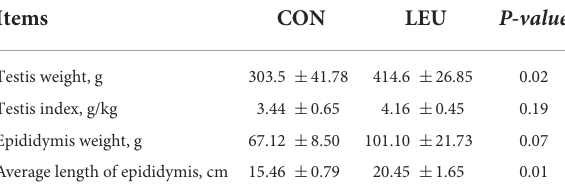
TABLE 2 Effects of dietary leucine supplementation on the development of testis and epididymis in 150-days-old boars.